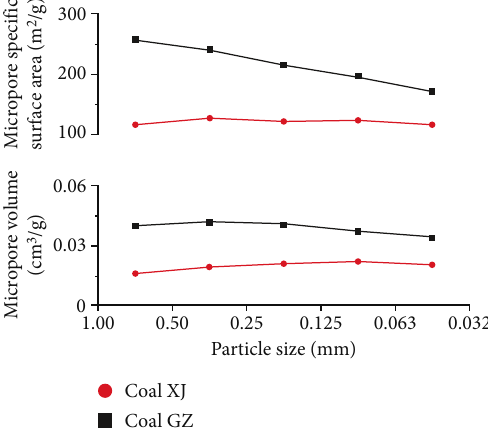
Figure 6: Low-pressure CO adsorption isotherms of the coal subsamples with di ff erent particle sizes: (a) Coal XJ; (b) Coal GZ. 2